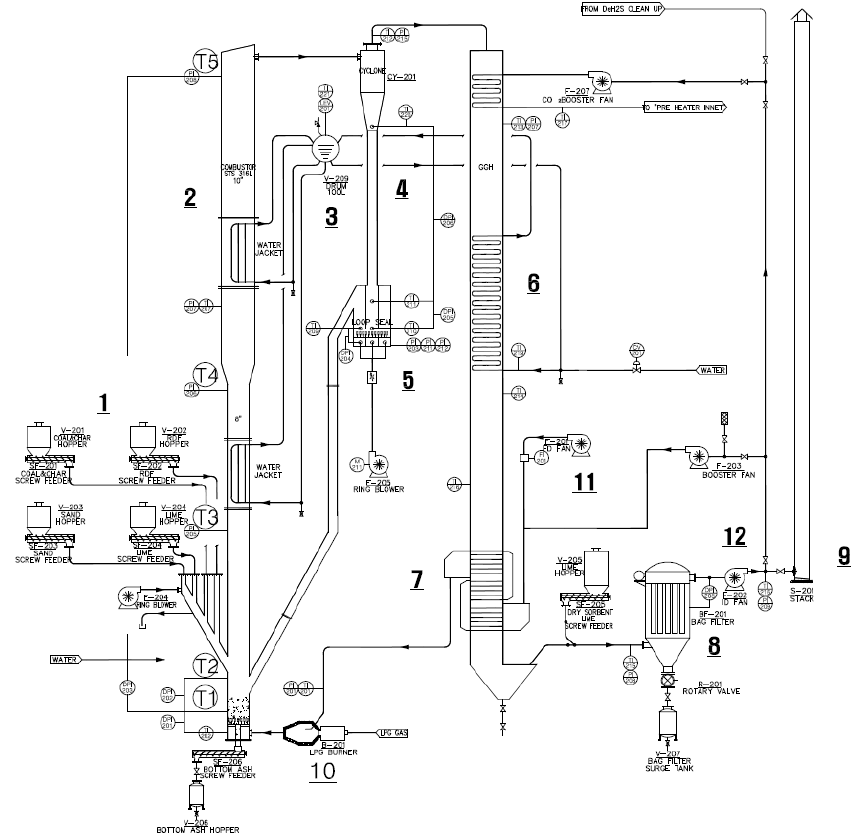
Figure 1. Schematic diagram of 0.1 MWth CFBC boiler. (1) Fuel and material injection unit, (2) com- bustor, (3) steam and water drum, (4) cyclone, (5) loop-seal, (6) economizer, (7) air preheater, (8)